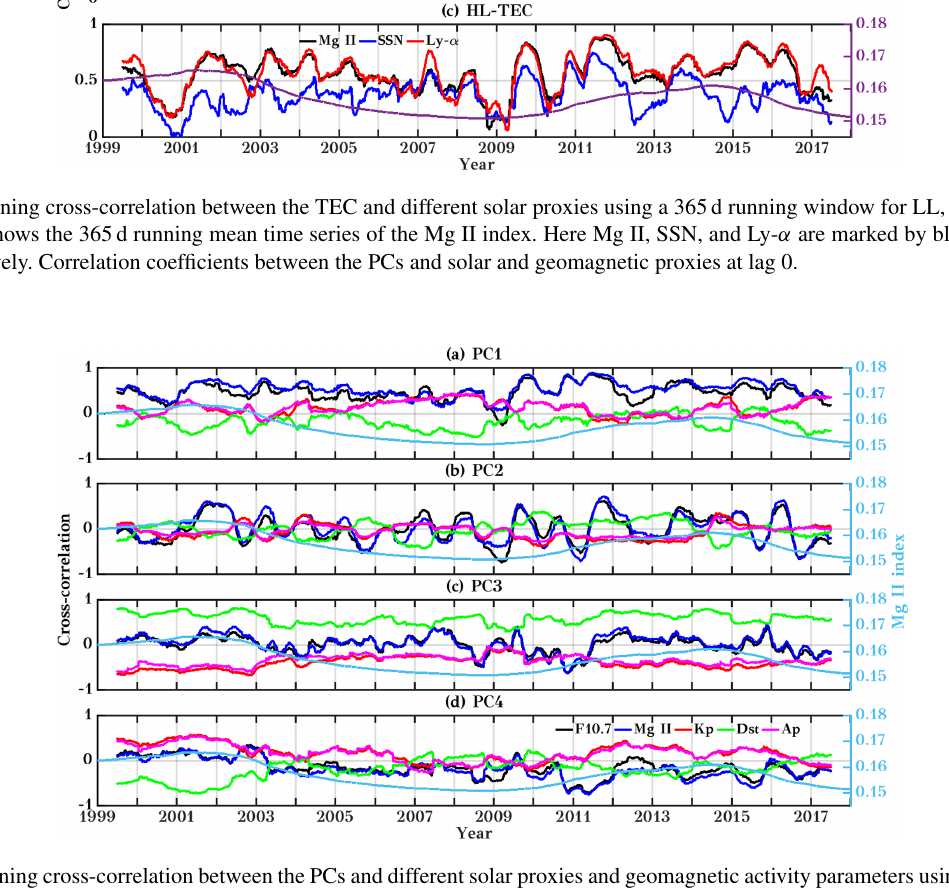
Figure A7. Running cross-correlation between the PCs and different solar proxies and geomagnetic activity parameters using a 365d running window. The second y axis shows the 365d running mean time series of the Mg II index. Here F10.7, Mg II, Kp, Dst, and Ap are marked by black, blue, red, green, and magenta colors,